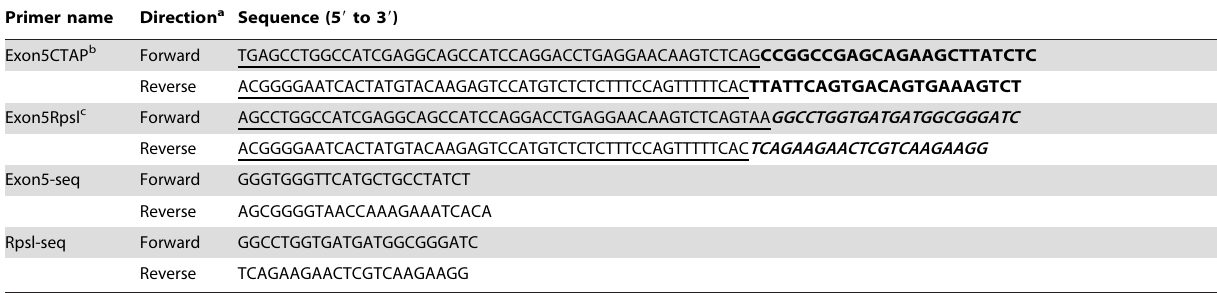
Table 1. Oligos used for fusing SG to the C-terminus of HCMV IE2 and for